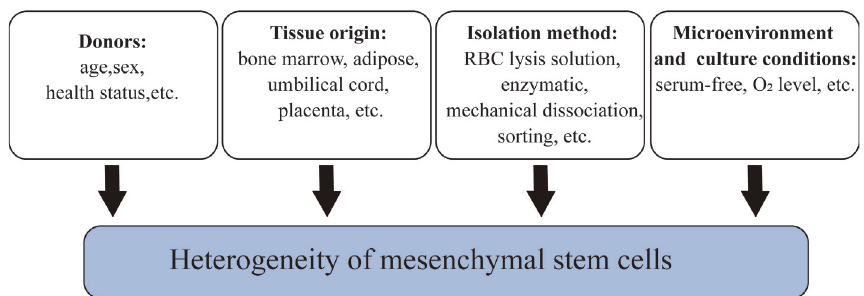
Fig. 1. Heterogeneity of mesenchymal stem